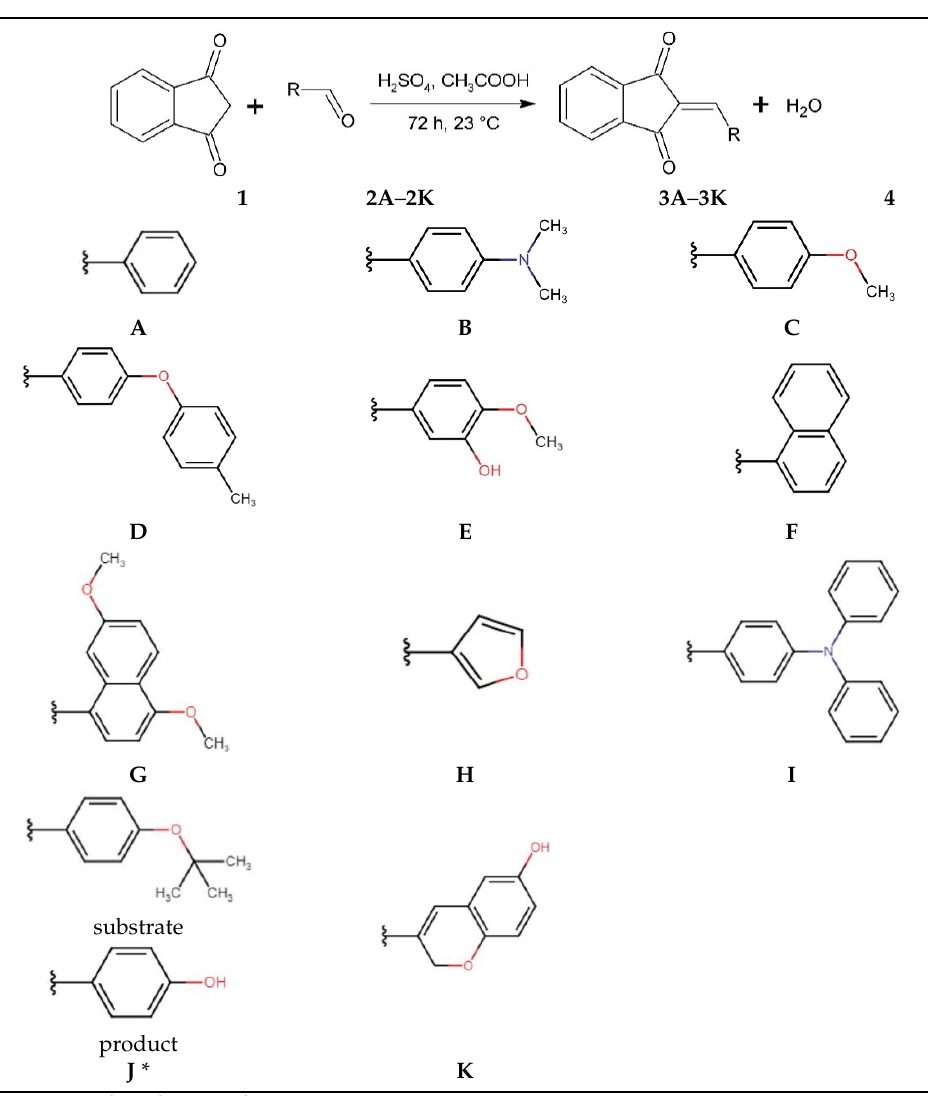
Table 6. General synthesis procedure.